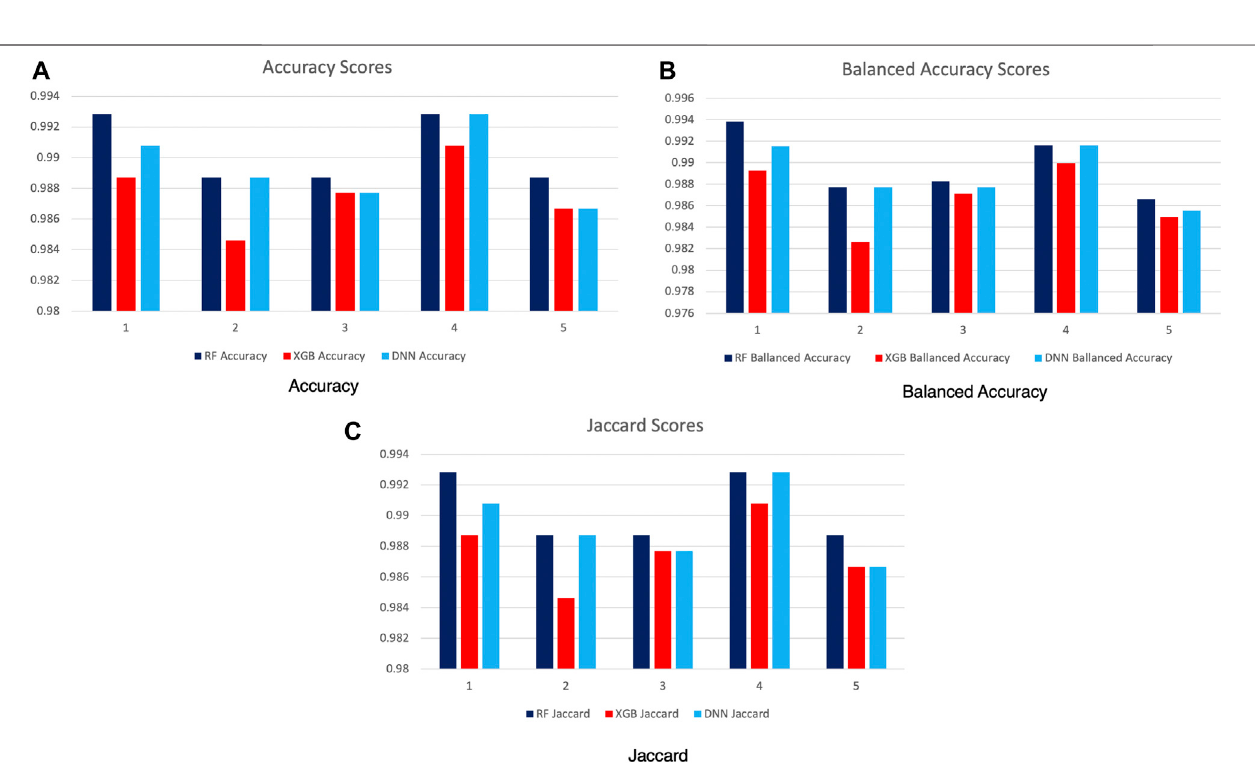
FIGURE 9 | Model scores with cross-validation